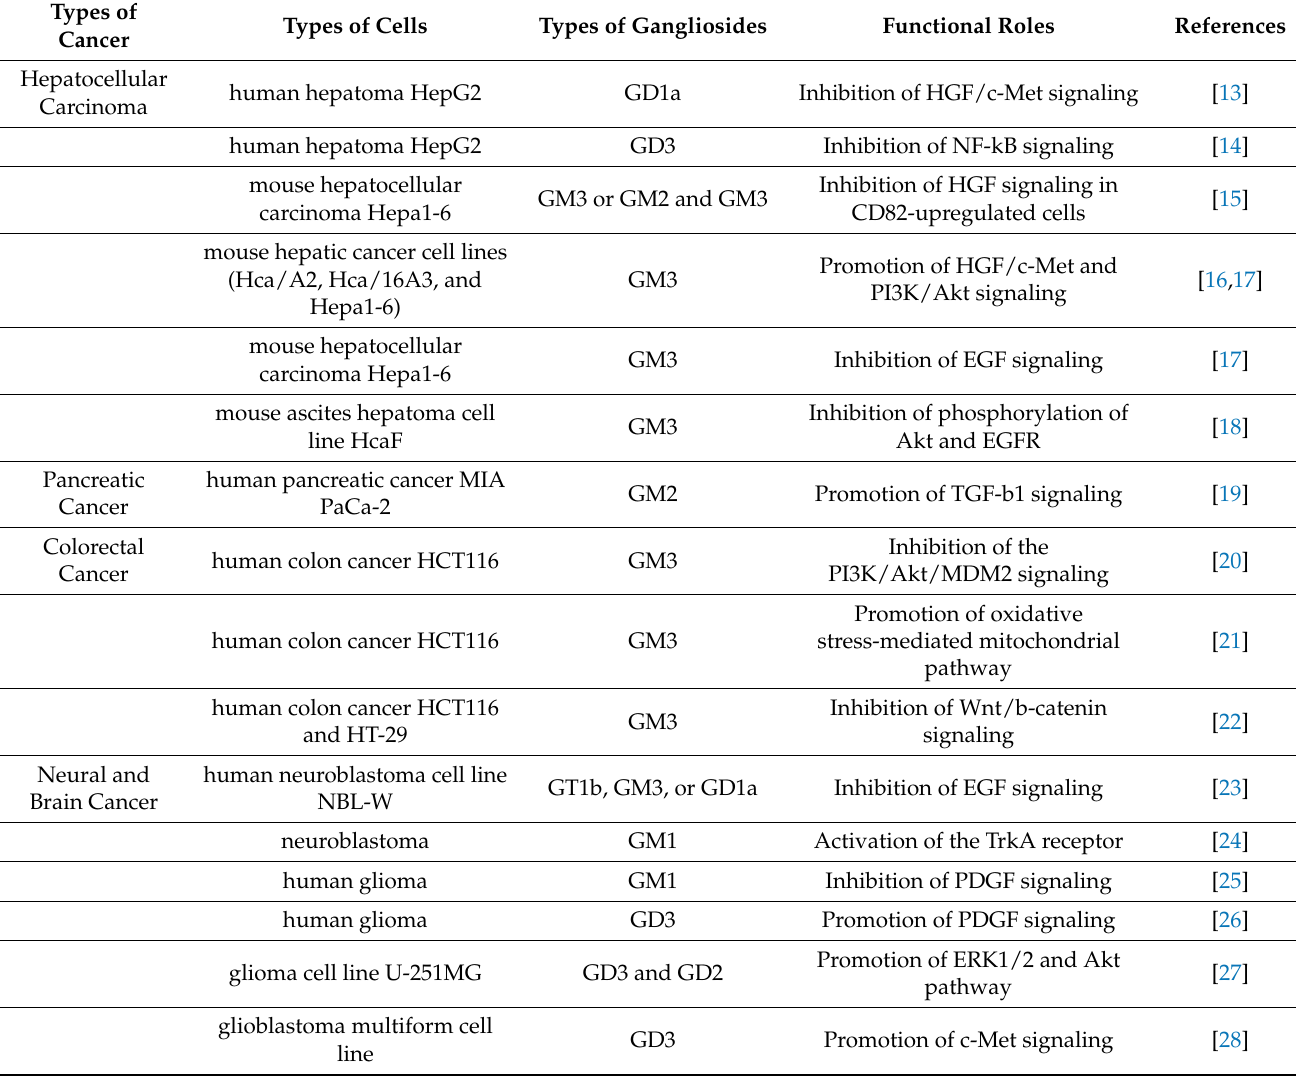
Table 1. Signal regulation of endogenous or exogenous gangliosides in cancer